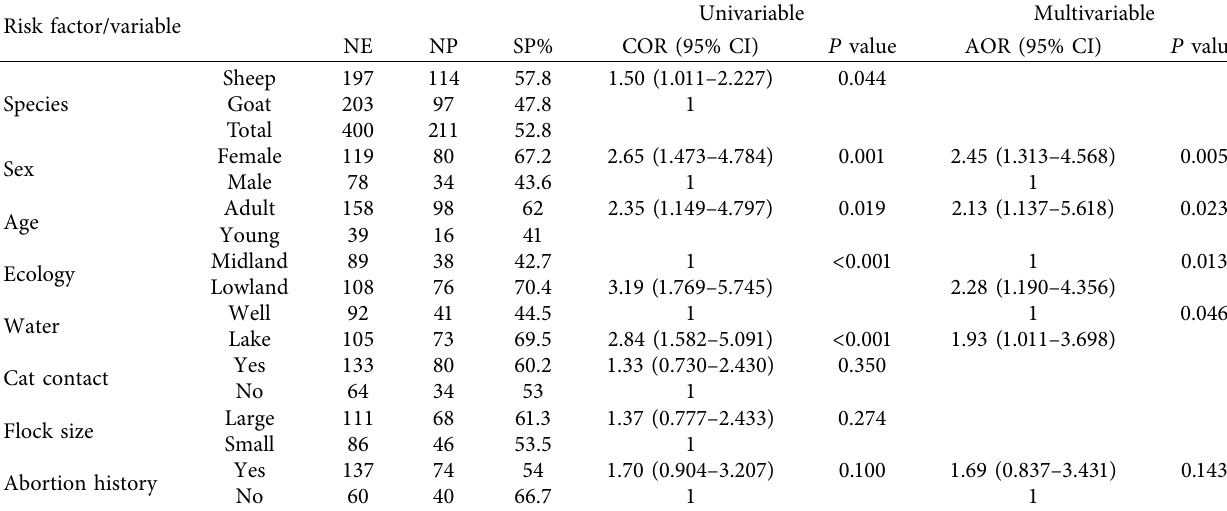
Table 2: Seroprevalence of T. gondii infection in sheep and goats of studied PAs of the Yabello district. Sheep Goat PA No. examined Darito Areri Obdaya Cholkasa